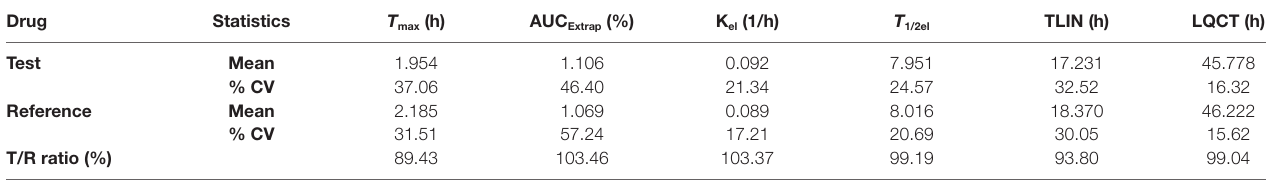
TABLE 9 | Secondary pharmacokinetic parameters for OLM after oral administration of single dose of test and reference tablets in human subjects ( n = 28).